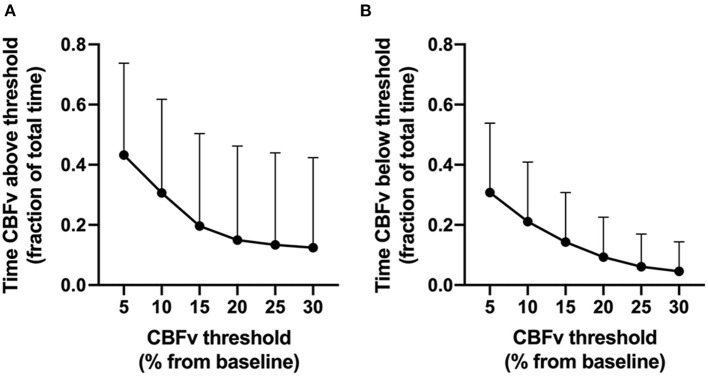
Proportion of analysis time that cerebral blood flow velocity (CBFv) deviated from baseline (y axis) above (A) or below (B) CBFv thresholds (x-axis). Error bars represent standard deviations.